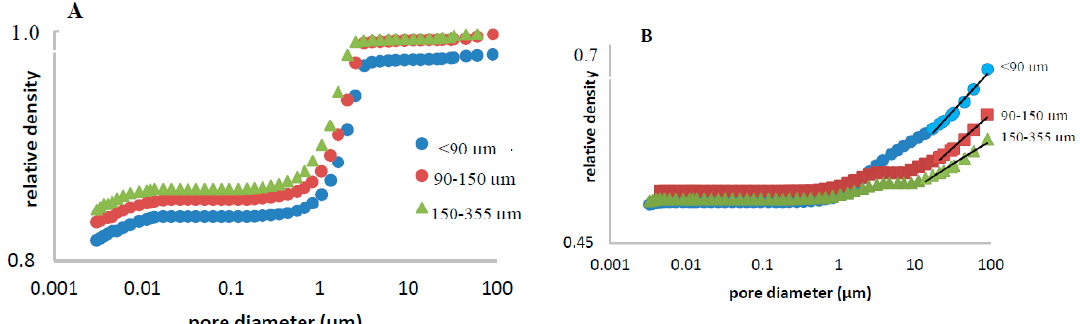
Figure 4. Determination of the volume fractal dimension of TPU matrices containing three different size fractions of theophylline, before ( A ) and after drug release study ( B ).